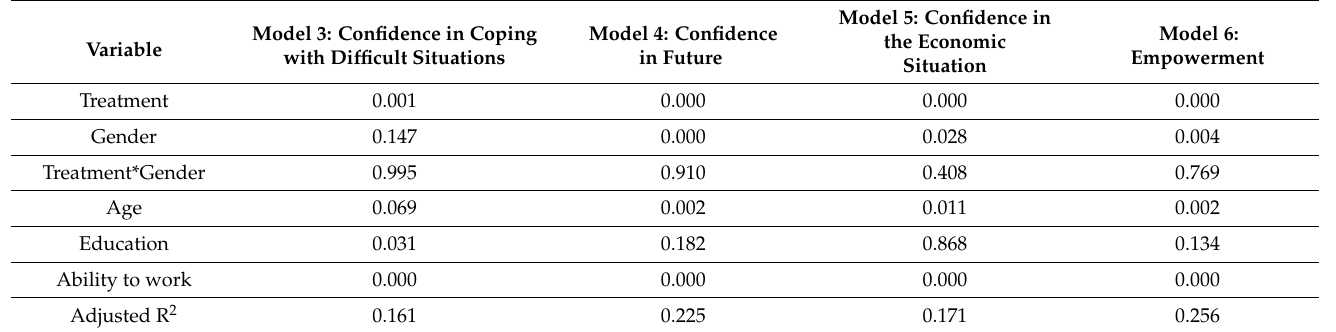
Table 3. General linear model on confidence in coping with difficult life situations, in the future, in the economic situation, and on empowerment (significance of